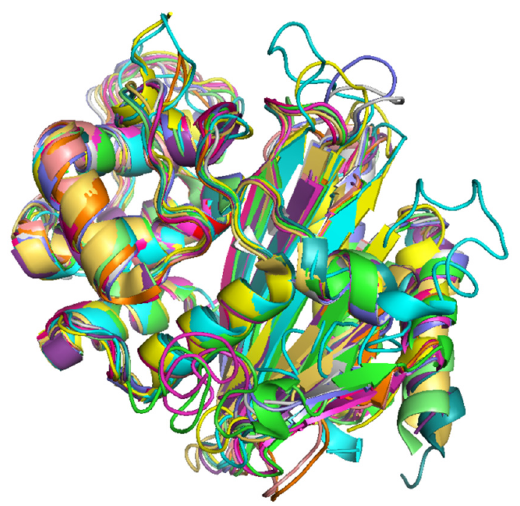
Figure 4. Superimposed 3D protein models of representatives of the 16 OXA subfamilies. (Color Key, Green: OXA-50-like, Cyan: OXA-9-like, Magenta: OXA-198-like, Yellow: OXA-1-like and OXA-33- like, Wheat: OXA-2-like, Grey: OXA-5-like, Blue: OXA-10-like, Orange: OXA-20-like, Light Green: OXA-23-like and OXA-134-like, Dark Green: OXA-24-like, Pink: OXA-48-like, Mustard: OXA-58-like, Purple: OXA-213-like and